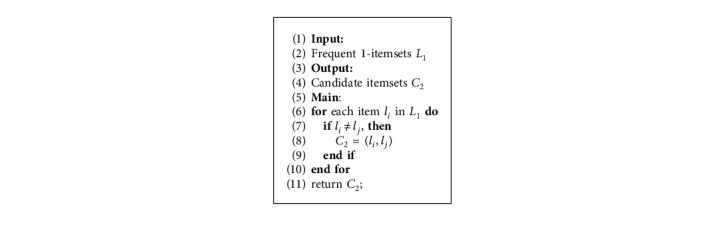
 Generating candidate itemsets C2.